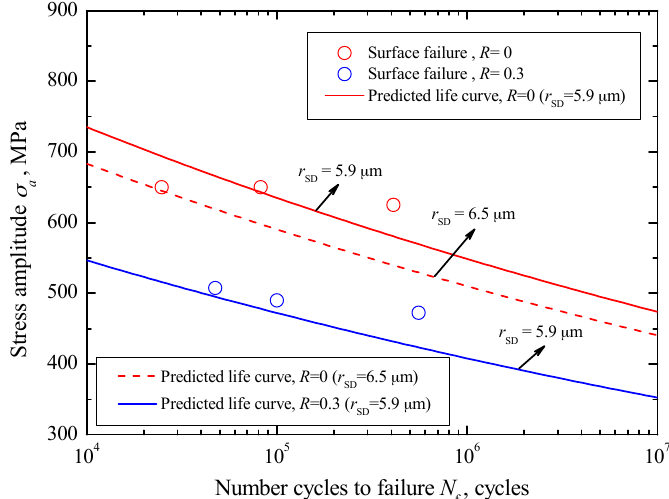
Figure 15. Predicted crack growth lives for surface failure.